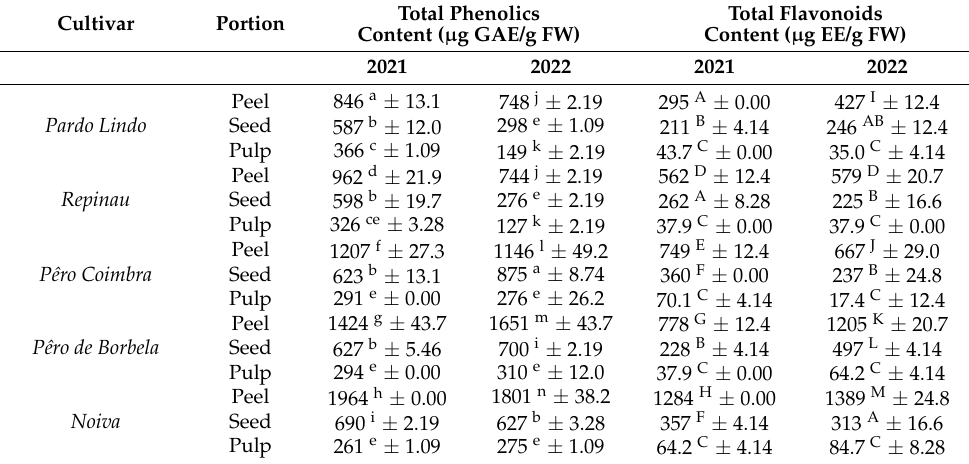
Table 4. Total Phenolics Content (TPC) and Total Flavonoids Content (TFC) of different portions of apple cultivars. Results are expressed in means ± standard